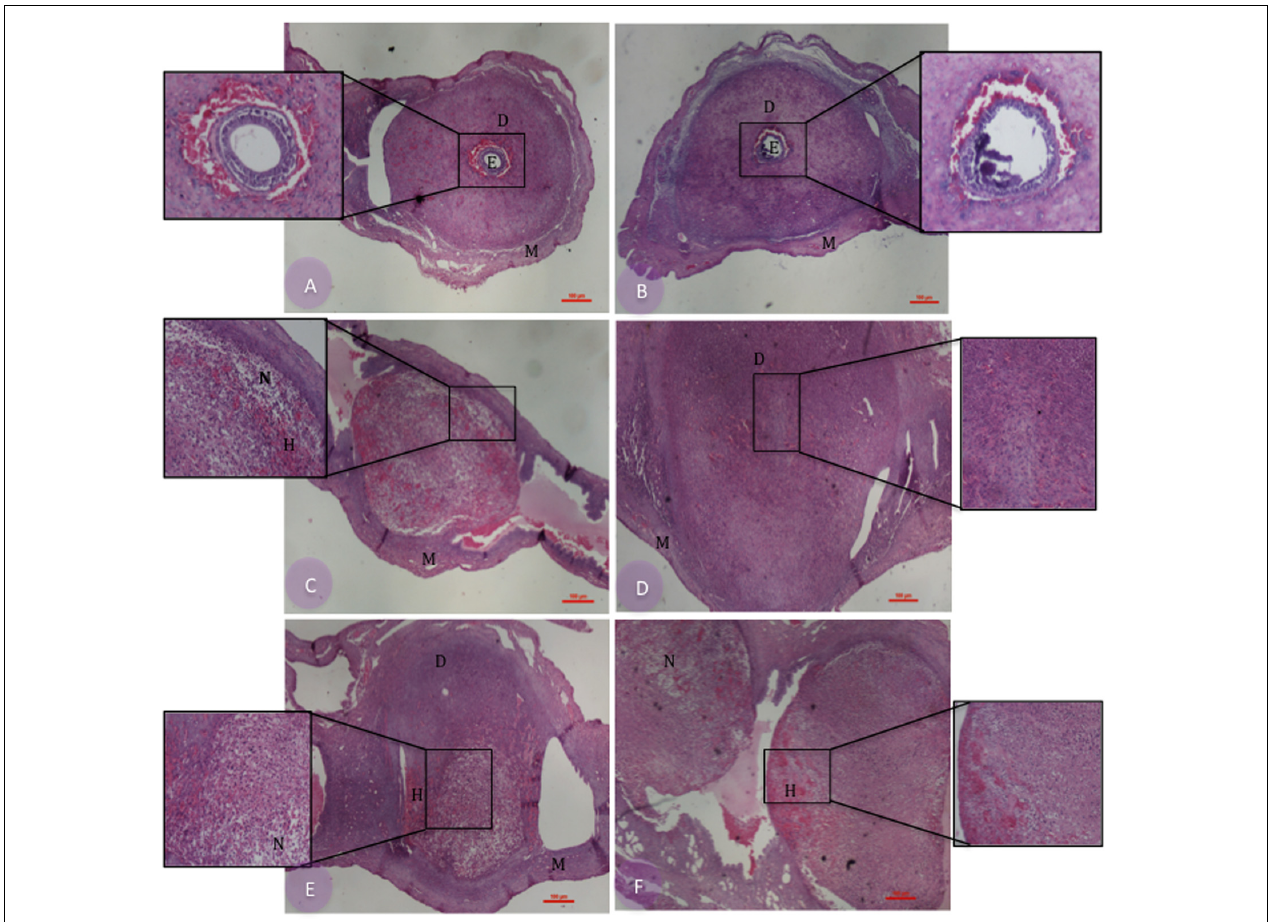
FIGURE 2 | Histopathological analysis of implantation sites from pregnant C57BL/6 MIF − / − and C57BL/6 WT mice infected or not by Toxoplasma gondii. Paraffin-embedded 4- µ m tissue sections were stained with hematoxylin-eosin. Pregnant/non-infected WT (A) and MIF − / − (B) controls; pregnant/infected WT (C,E) and MIF − / − (D,F) females. E, embryo; D, decidual zone; M, myometrium; N, decidual cells in necrosis; H, hemorrhagic areas. Bar scale = 100 µ M. The inserts in the figures show increased magnification of the selected area (original magnification in the insert is 10x).